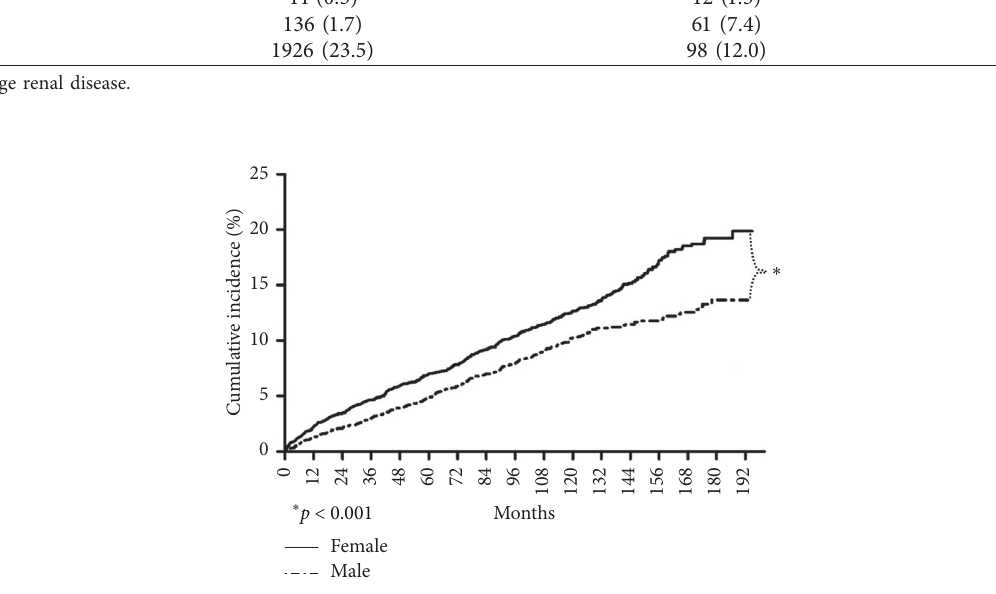
Figure 4: The cumulative incidence of cataracts in the type 1 diabetes group divided by